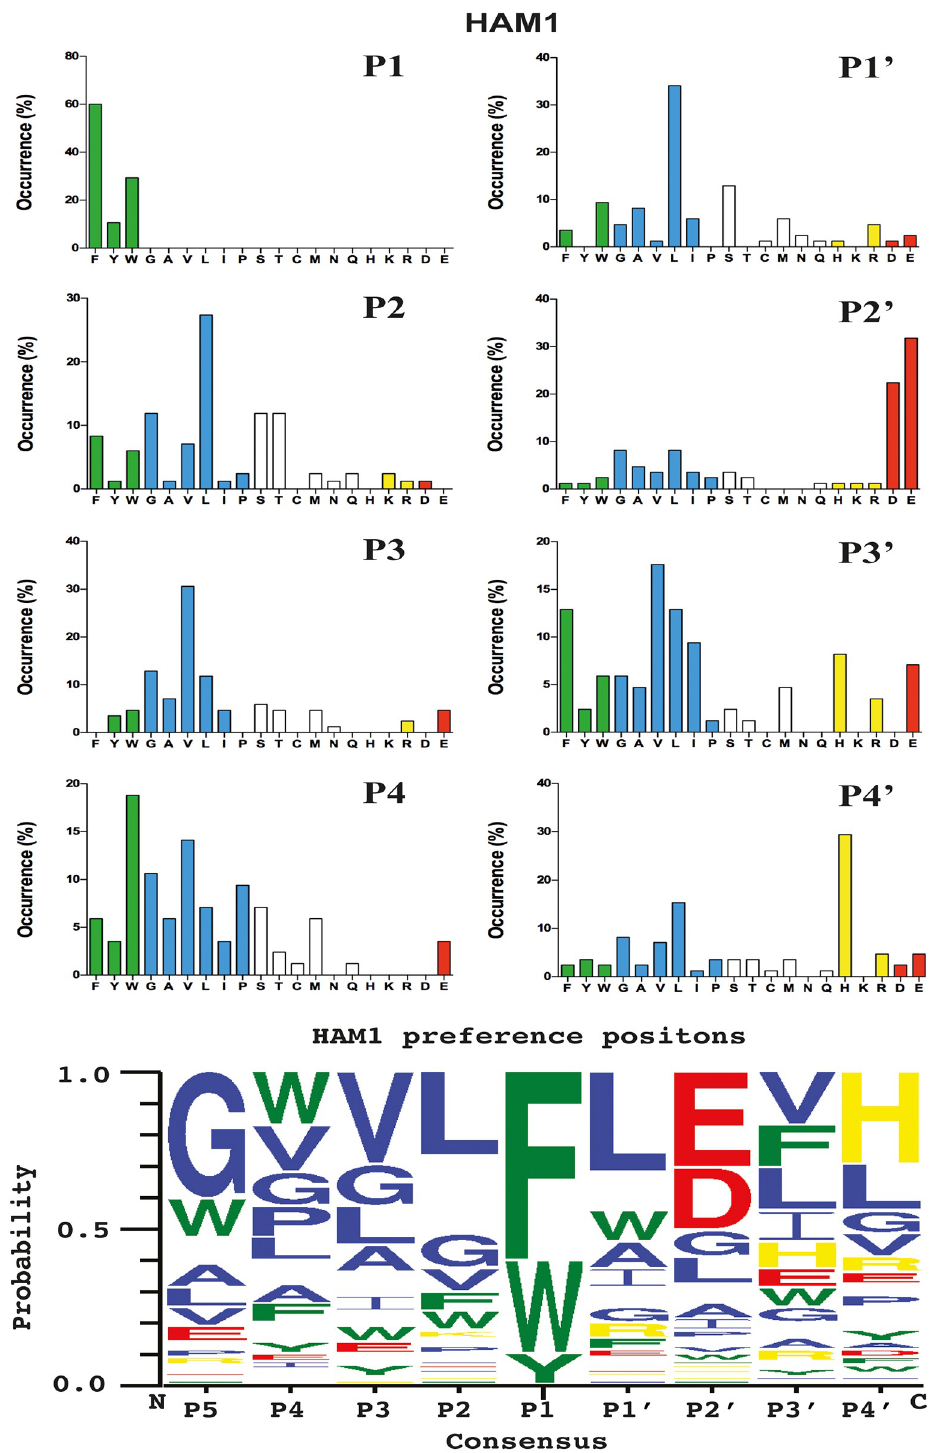
Fig 5. Distribution of amino acids in positions P4 to P4´ in phage displayed nonamers cleaved by HAM1 after five biopannings. Based on the alignment in Fig 4 the percentage of each amino acid present in each position P4 to P4´ as calculated. The amino acids are ordered from left to right: aromatic, aliphatic, hydrophilic, basic (positively charged) and acidic (negatively charged). In the bottom of the figure we have used the computer program WebLogo to generate an illustration of the relative distribution of the amino acid preferences for cleavage by HAM1 as obtained from the phage display analysis.